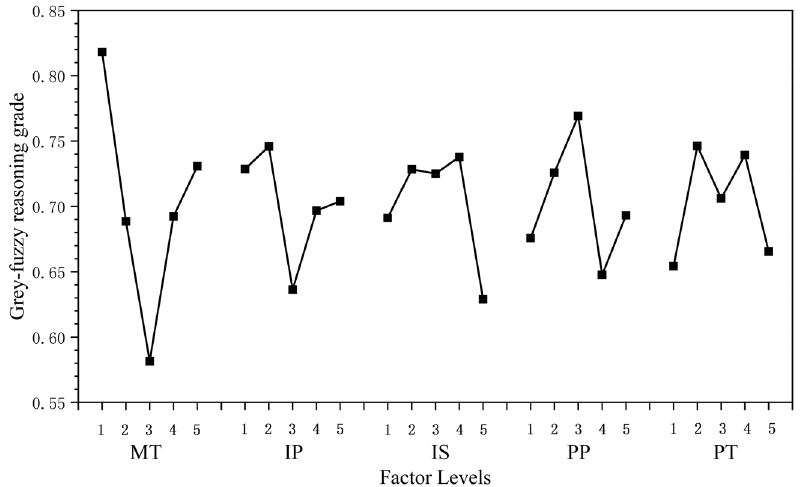
Figure 9. The main effect diagram of factors on GFG.